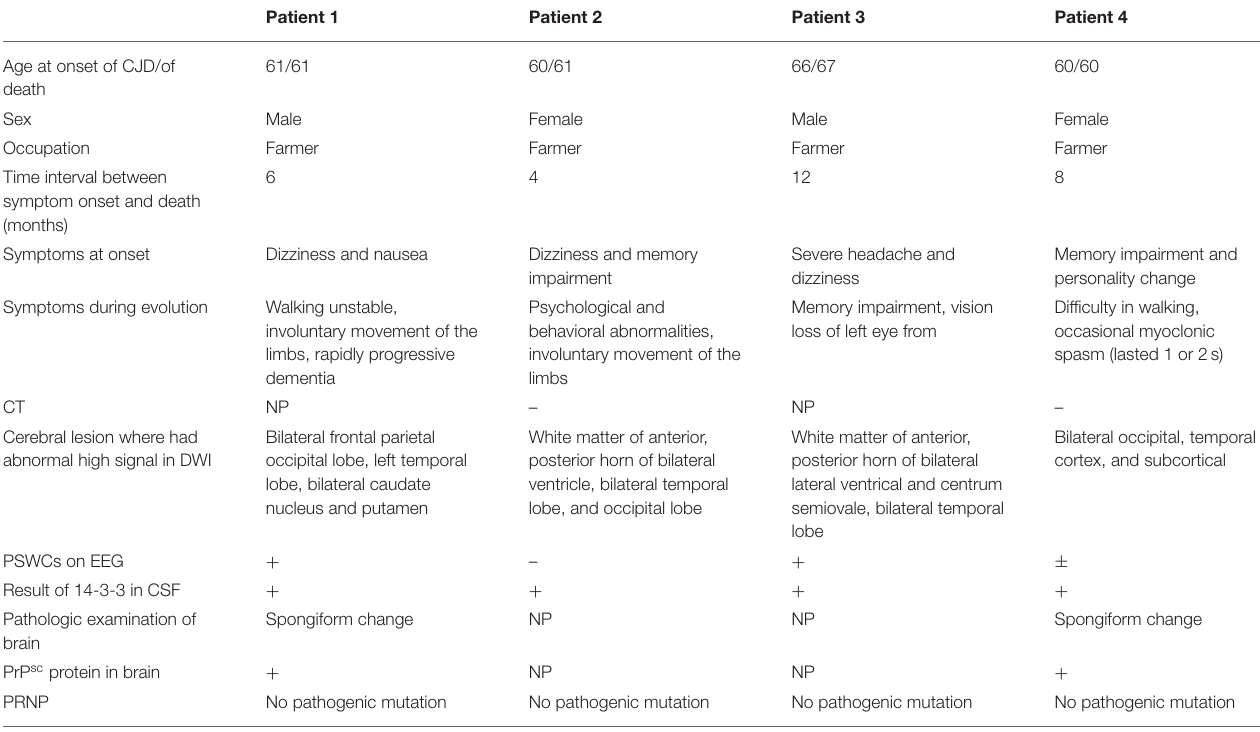
TABLE 1 | Clinical features and results of assistant examination in